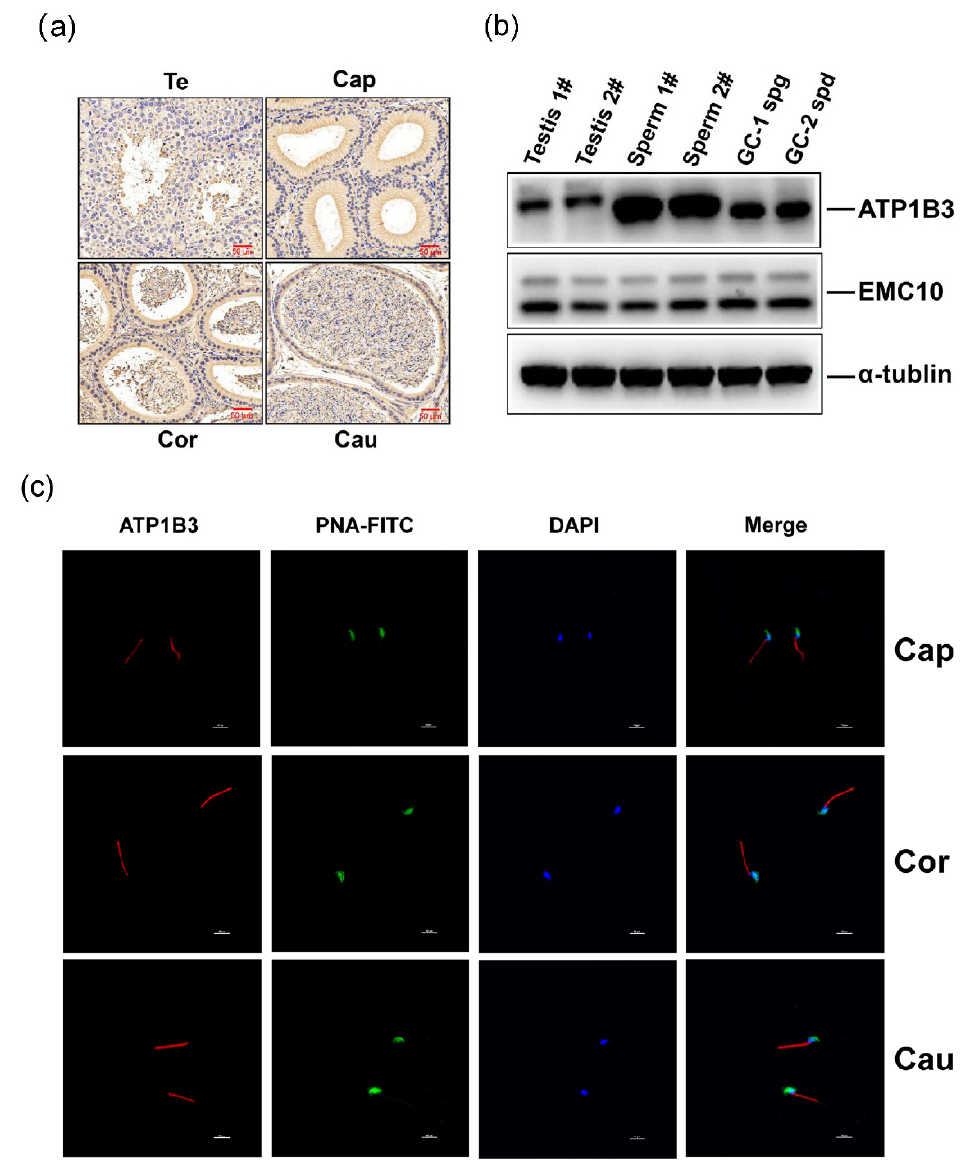
Figure 2. ATP1B3 expression and localization in male germ cells of mouse. ( a ) Immunohistochemistry analysis of ATP1B3 in the testis and epididymis tissues of mouse. Scale bar = 50 µ m. ( b ) EMC10 and ATP1B3 protein expression measured in the testis, spermatozoa, GC-1, and GC-2 cells by Western blotting. ( c ) Immunofluorescence analysis of ATP1B3 localization (red) in spermatozoa from mouse epididymis (100 × ). Scale bar = 10 µ m. Te, testis; Cap, caput epididymis; Cor, corpus epididymis; Cau, cauda epididymis; PNA-FITC (green), sperm acrosome; DAPI (blue), sperm nucleus.